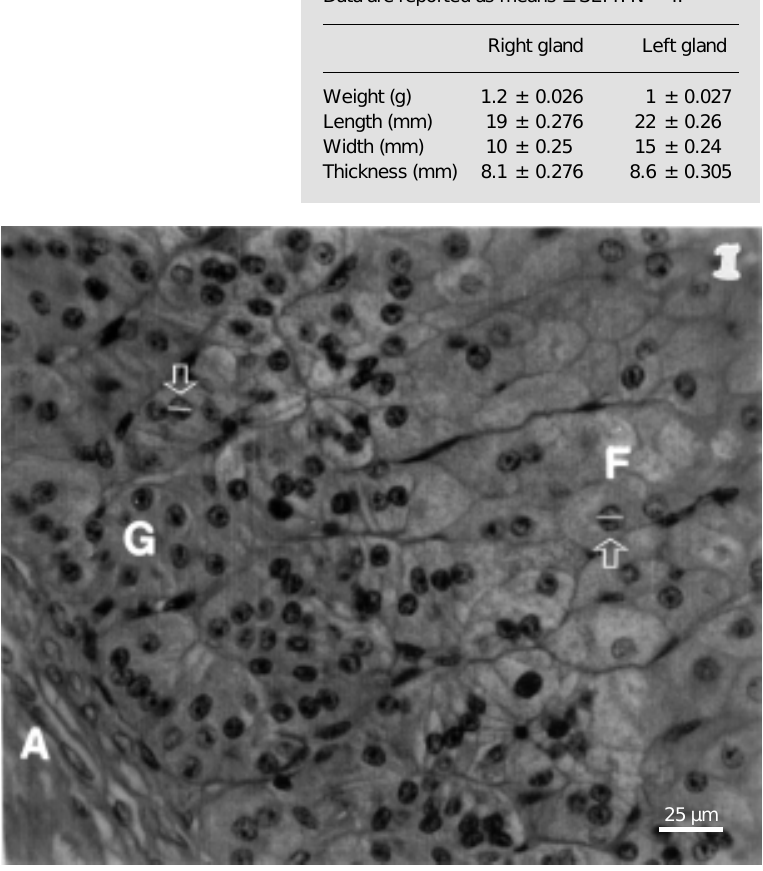
Figure 1 - Glomerulosa and fasciculata regions of a viscacha captured in March (summer). Notice the thick capsule of connective tissue (A). In the glomerulosa zone (G) the cells are clustered in the form of tube-shaped structures. Notice the characteristics of the fine chromatin nuclei and the nuclear diameter of the cells (line indicated by the arrow). The fasciculata region (F) shows large cells with central nuclei. The line shows the nuclear diameter of one of its cells. H-E; 400X.